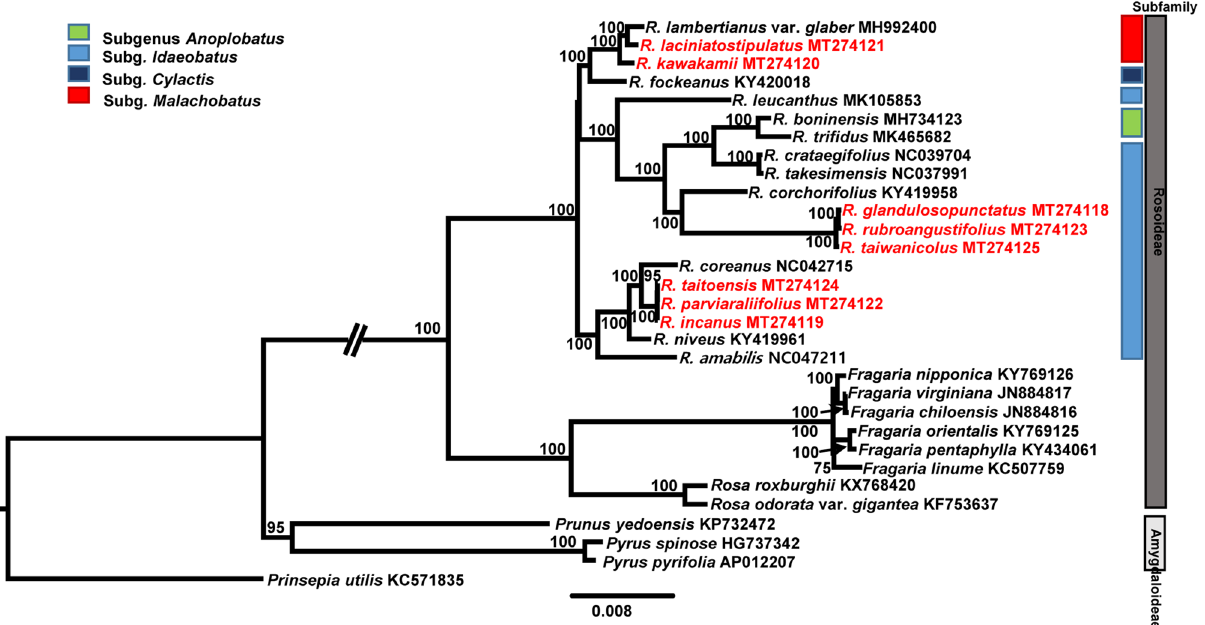
Figure 7. The maximum-likelihood (ML) tree using IQ-TREE v. 1. 4. 2. (http://www.iqtre e.org/) inferred from 31 representative species of Rosaceae. The complete plastomes of eight Rubus endemic species from Taiwan are labeled in red. The bootstrap value based on 1,000 replicates is shown on each node. Prinsepia utillis was used as an outgroup and columns on the right indicate two subfamilies of Rosaceae, Rosoideae and Amygdaloideae, and subgeneric classification of Rubus ( Anoplobatus , Idaeobatus , Cylactis , and Malachobatus